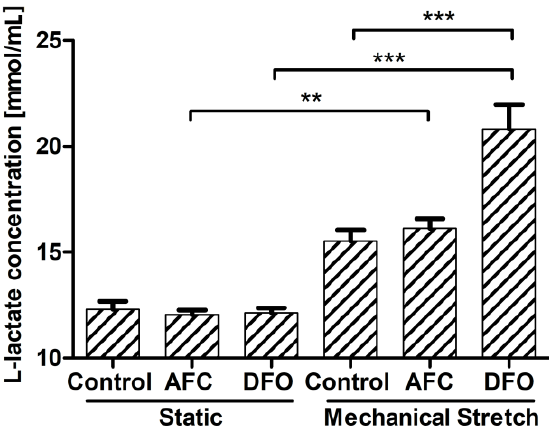
Figure 4. Concentration of extracellular L -lactate measured in medium of HCM cells cultured either in static conditions or upon mechanical stretch with concomitant optimal, increased or reduced iron availability conditions. ** p < 0.01; *** p < 0.001. AFC, ammonium ferric citrate; DFO, deferroxamine.